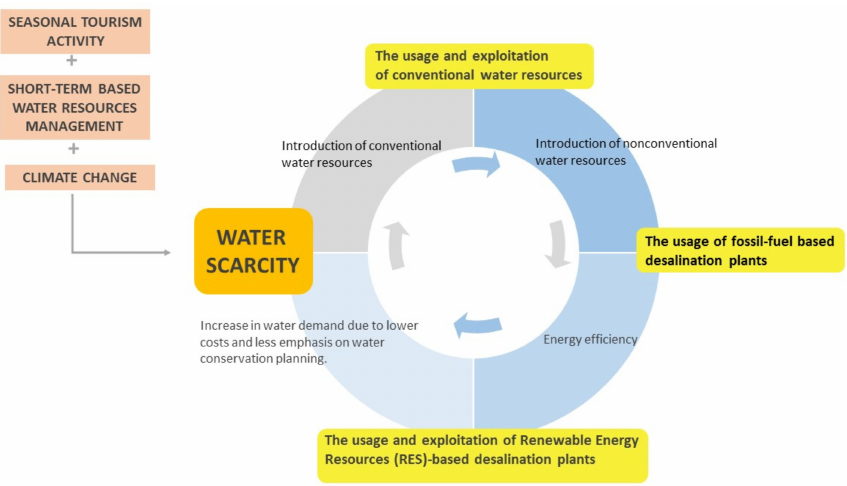
Figure 1. Vicious cycle of desalination plant use at water-scarce island tourism